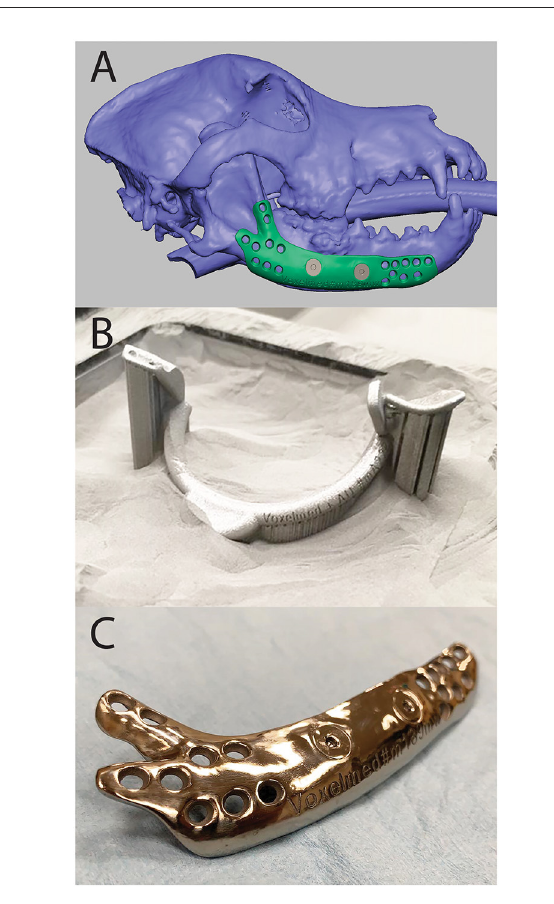
FIGURE8 Photographs (A,B) of the soft tissue damage and volumetric renderings of the right (C) and left (D) sides depicting the hard tissue damage of the patient in case